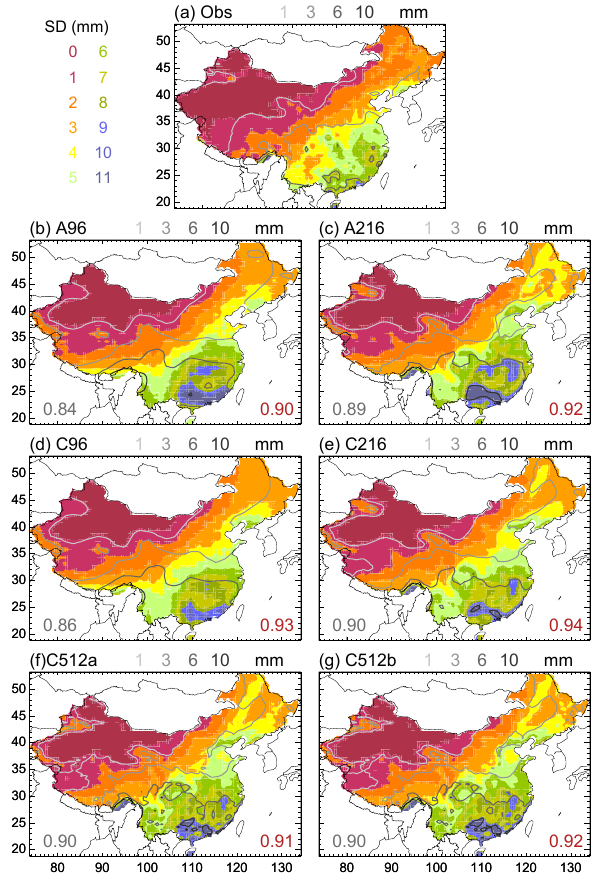
Figure 1. Climatological MJJASO total precipitation (gray con- tours) and standard deviation of pentad precipitation (shading) for 1982–2007 observations (a) and the full length of each simulation. Units are mmday − 1 . All data are interpolated to the APHRODITE grid. The gray number on the bottom left is the linear pattern cor- relation coefficient between simulated and observed total precipi- tation; the red number on the bottom right is that for the standard deviation of pentad